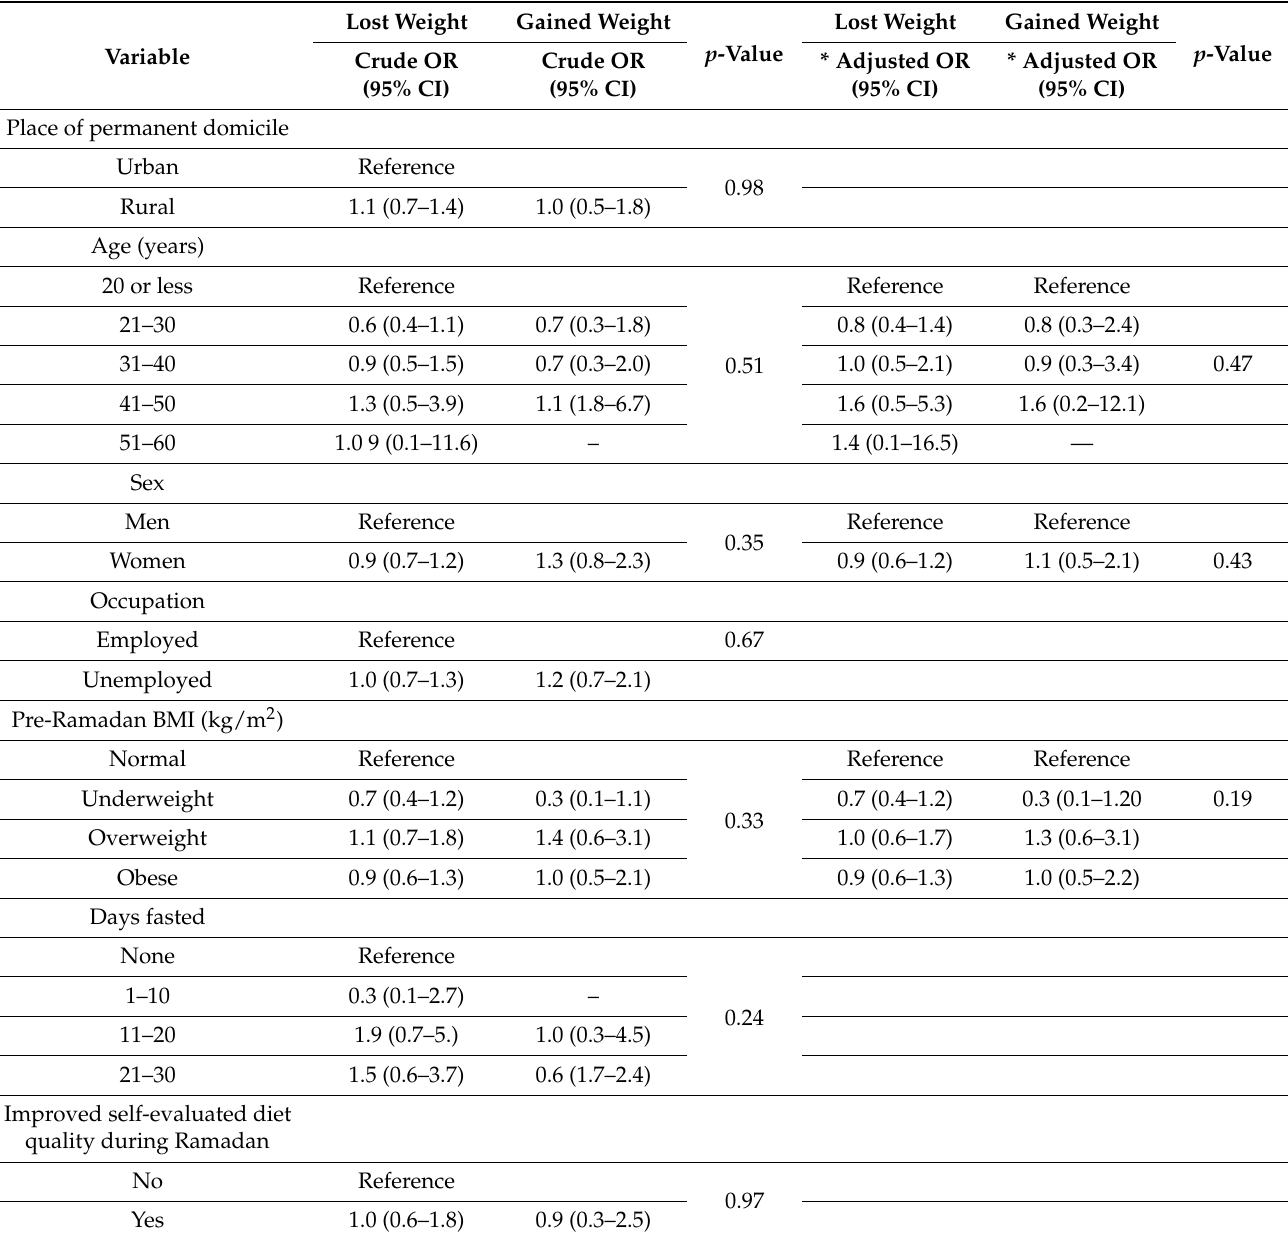
Table 3. Multinomial logistic regression showing crude and adjusted ORs of risk factors associated with weight loss and gain during Ramadan, N =